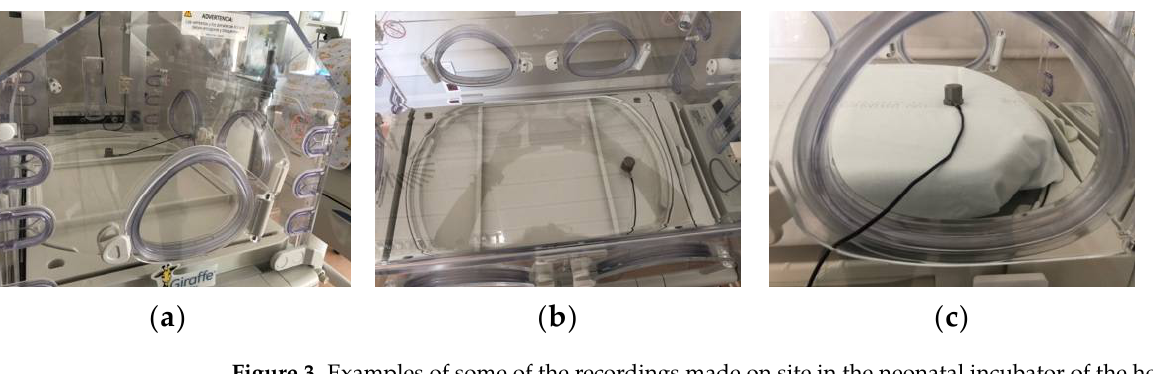
Figure 2. Positions of the recordings made in the incubator.